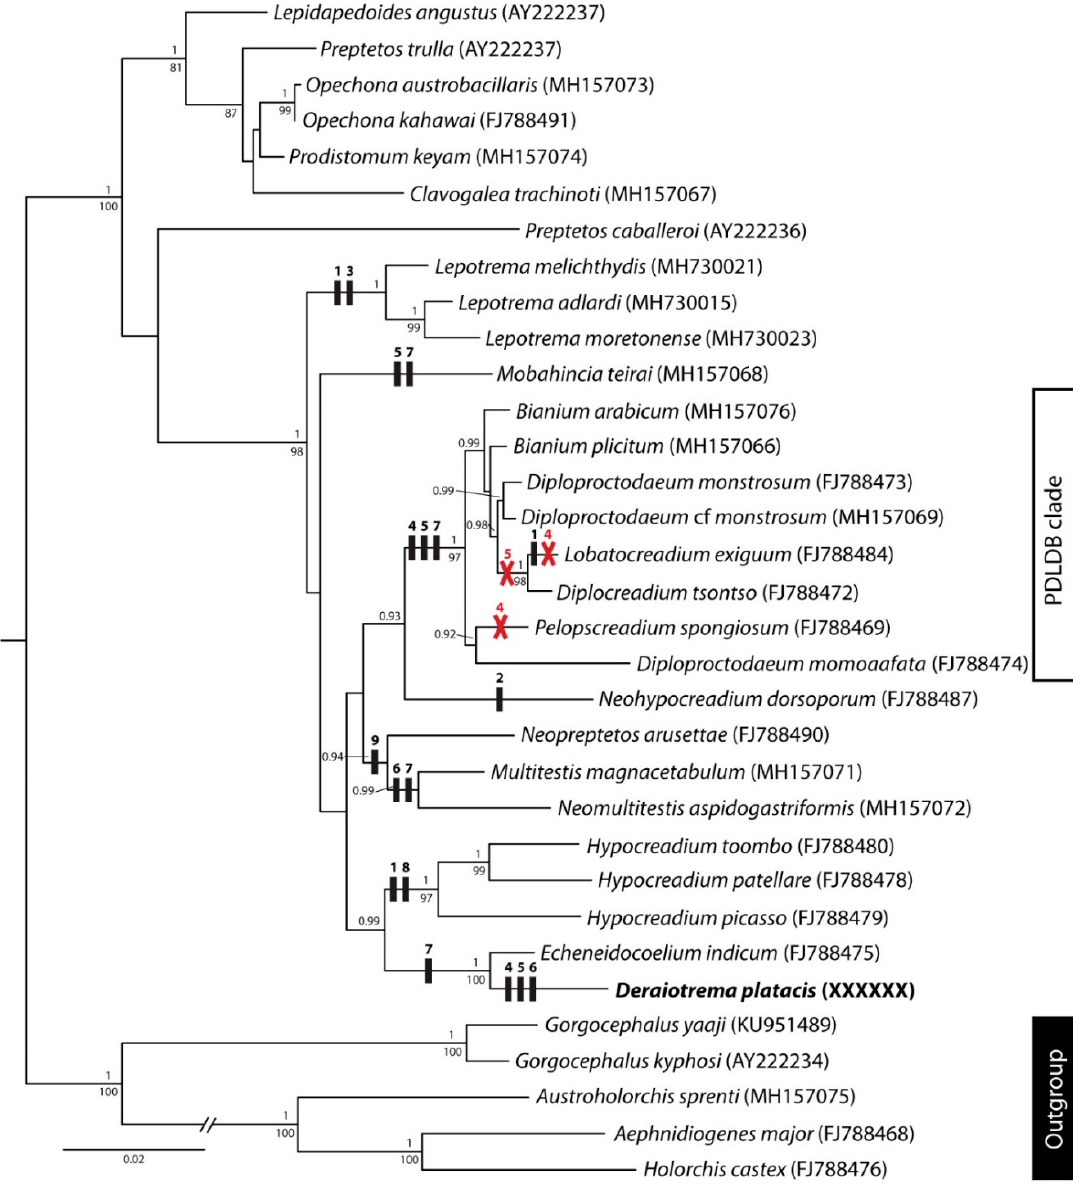
Figure 2. Relationships between members of the Lepocreadiidae based on maximum likelihood analysis of the partial 28S rDNA dataset. Homoplasious characters are numbered on the phylogram; black vertical bar indicates the acquisition of a character, a red cross the loss of character or reacquisition of the ancestral state. 1, Distinctly dorsal excretory pore; 2, Distinctly dorsal genital pore; 3, Muscular metraterm bulb; 4, Folds/flanges in forebody; 5, Caeca abutting body wall (? ani formed); 6, Multiple testes; 7, Multilobate/acinous ovary; 8, Flattened circular body; 9, Uterus reaches posterior to gonads. Bayesian inference posterior probabilities are shown above the nodes and maximum likelihood bootstrap support values below. Support values <0.80 and <80 are not shown. Abbreviations : PDLDB clade, Pelopscreadium / Diploproctodaeum / Lobatocreadium / Diplocreadium / Bianium clade.